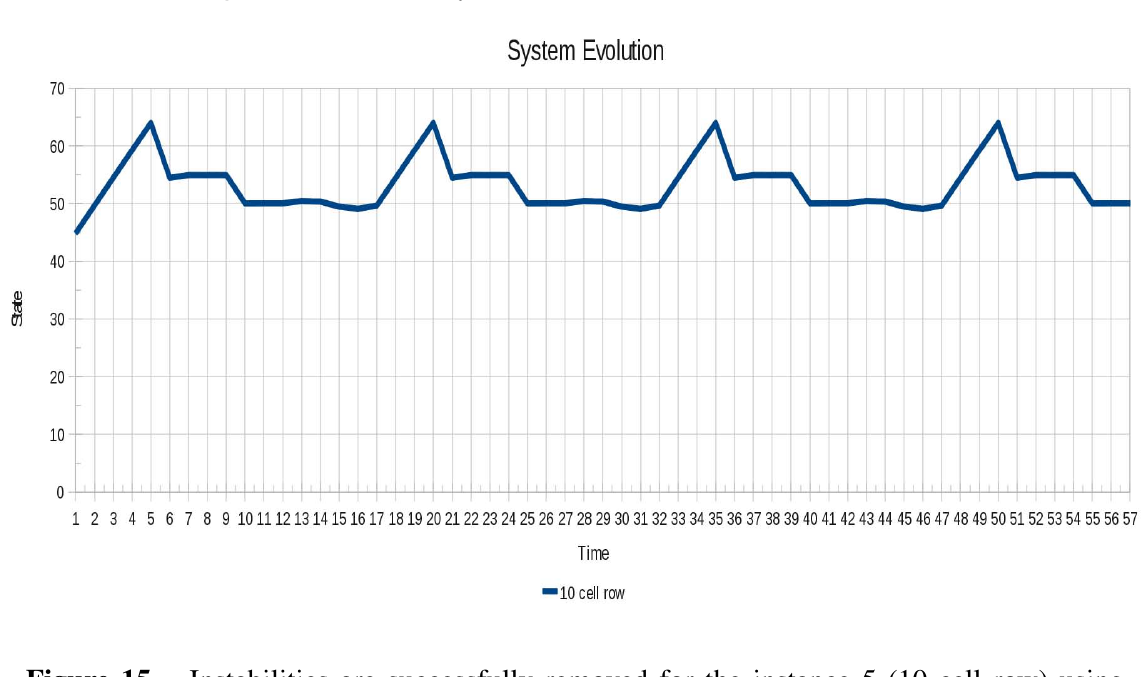
Figure 14. Oscillatory behavior of the instance 5 (10 cell row).